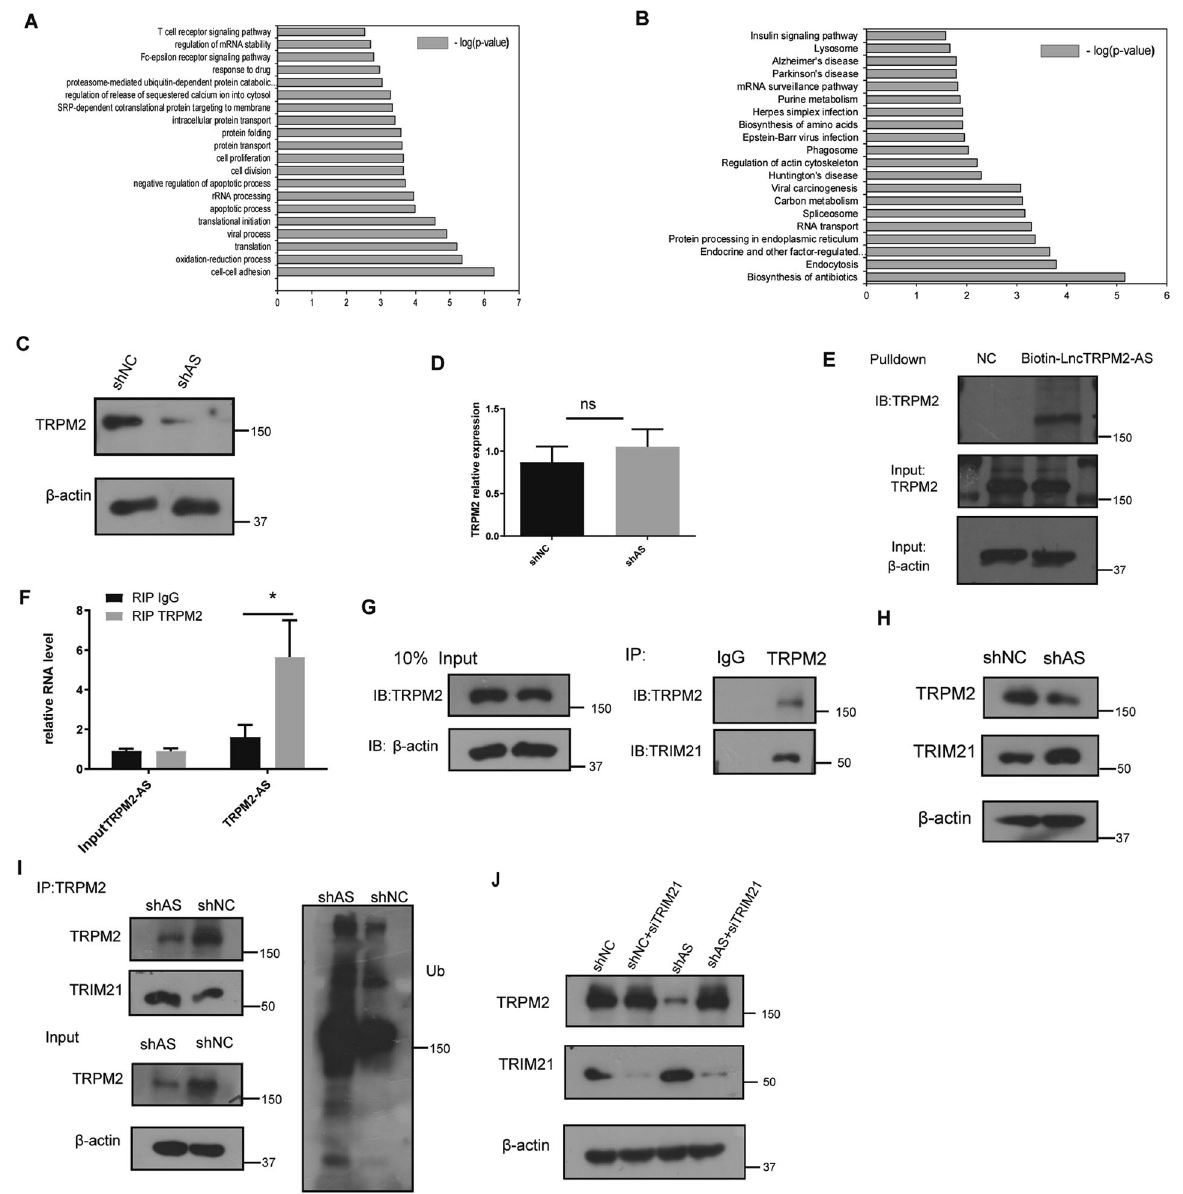
Fig. 3 LncTRPM2-AS regulates TRPM2 protein expression. A GO analysis and B KEGG analysis showed the differentially expressed protein- coding genes in shNC and shlncTRPM2-AS cells. C TRPM2 protein levels were assessed by Western blot. D The experession of TRPM2 mRNA level in shAS cells was detected by qPCR. E The interaction between lncTRPM2-AS and TRPM2 was con fi rmed by RNA pull-down and Western blot. F RIP was performed using anti-TRPM2 and control IgG antibodies, followed by real-time PCR to examine the enrichment of lncTRPM2-AS and β -actin. β -actin served as the negative control. G The interaction between TRPM2 and TRIM21 was con fi rmed by co-immunoprecipitation (IP). H Detection of TRPM2 and TRIM21 protein in shNC and shAS cells. I TRPM2 antibodies were used for co-immunoprecipitation (IP) in shNC and shAS lysates, and TRIM21 and ubiquitin levels were detected. J Detection of TRPM2 and TRIM21 protein in shNC and shAS cells transfected with siTRIM21. Bars, ± SD; n = 3, ns not signi fi cant; * P <